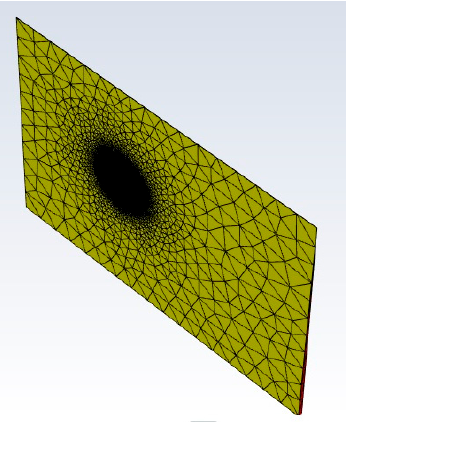
Figure 2. Computational fluid dynamics (CFD) mesh (wind from the left, 3.4 million of cells). ( a ) Outline of the CFD domain. ( b ) Mesh around the optimal diffuser. Table 1. Domain and boundary conditions ( D : rotor diameter, c : diffuser chord length).